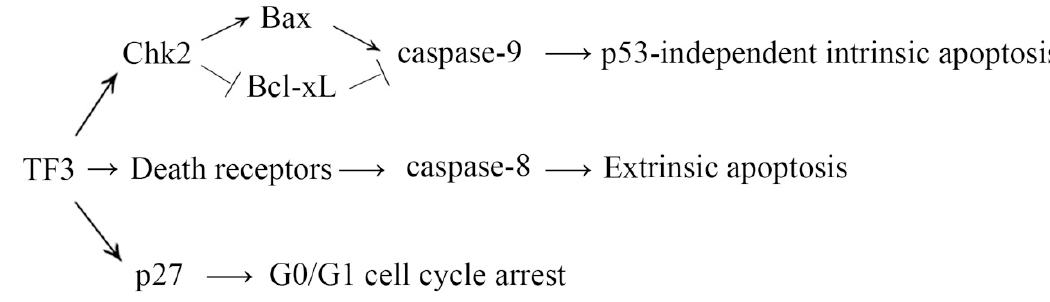
Figure 5. Proposed mechanism for the inhibition of TF3 in OVCAR-3 cells.